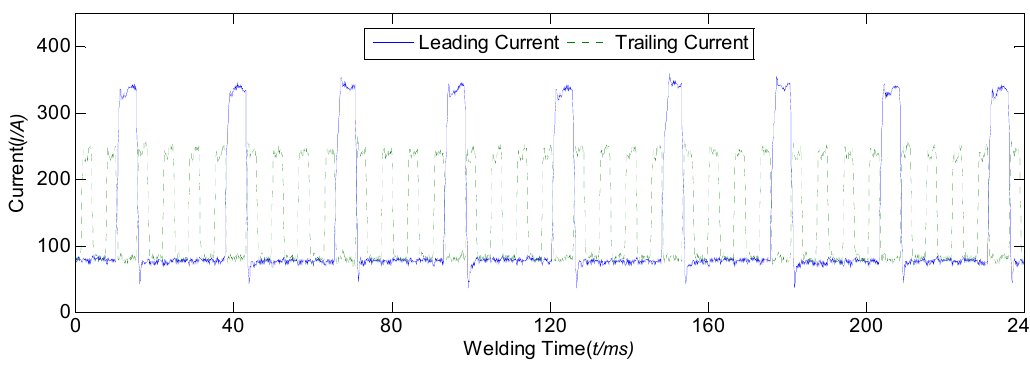
Figure 8. Current waveform of experiment 13.